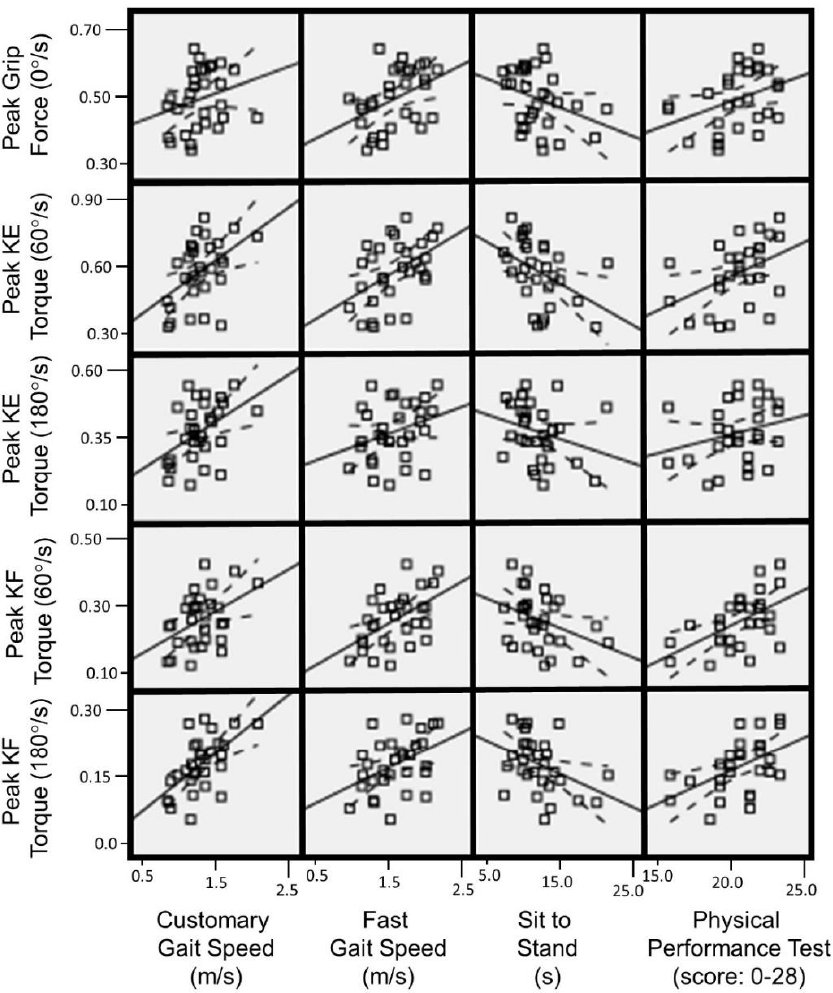
Figure 2. Matrix scatter plot for strength and physical performance measures (KE, knee extensor; KF, knee flexor; within each cell the solid line is the line of best fit, and the curved dashed lines are the 95% confidence intervals; strength values are scaled to body weight and are unitless; the Physical Performance Test is the seven-item version of the observed performance battery).